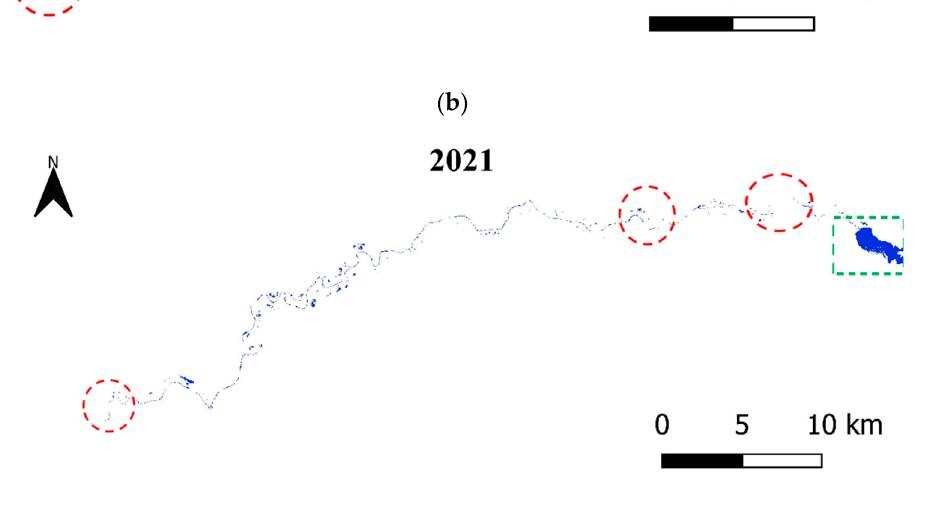
Figure 5. Extracted water masks for: ( a ) 1989; ( b ) 2005; ( c ) 2021.